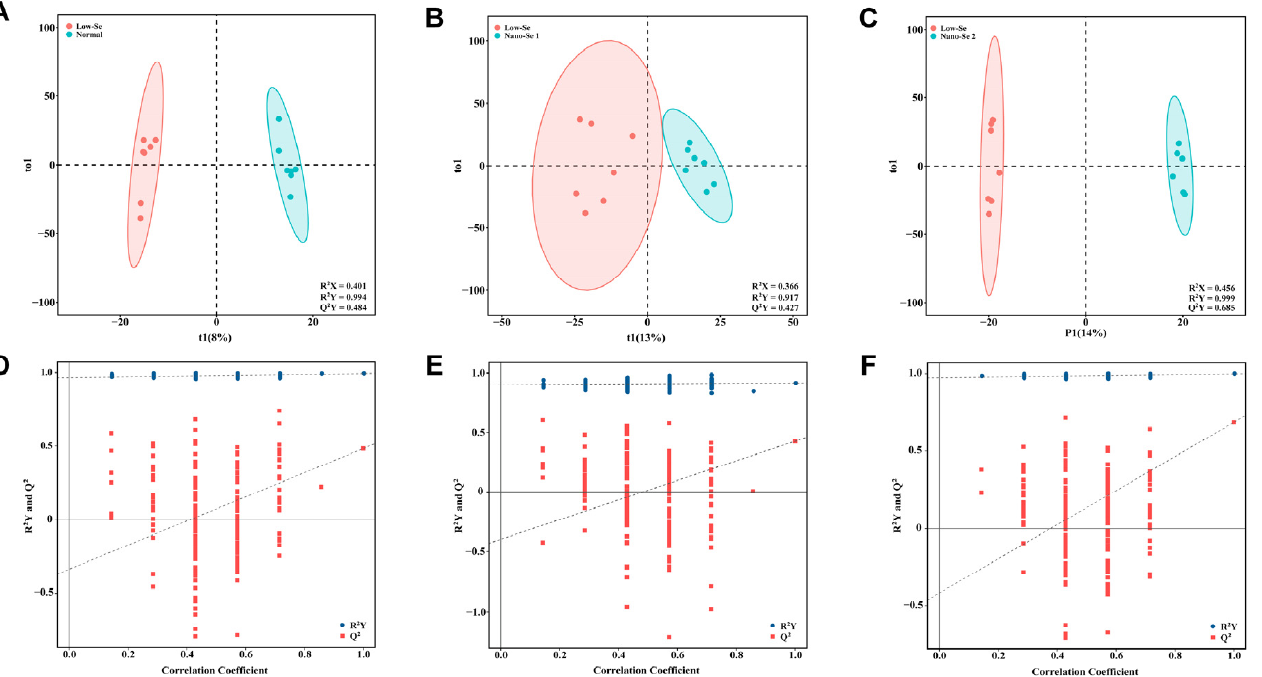
Figure 2. Qualitative analysis of differential metabolites between different groups. ( A – C ) OPLS-DA for metabolomics results of liver samples between different groups. ( D – F ) Permutation test results of OPLS-DA models between different groups. Se: selenium; OPLS-DA: orthogonal partial least-squares discriminant